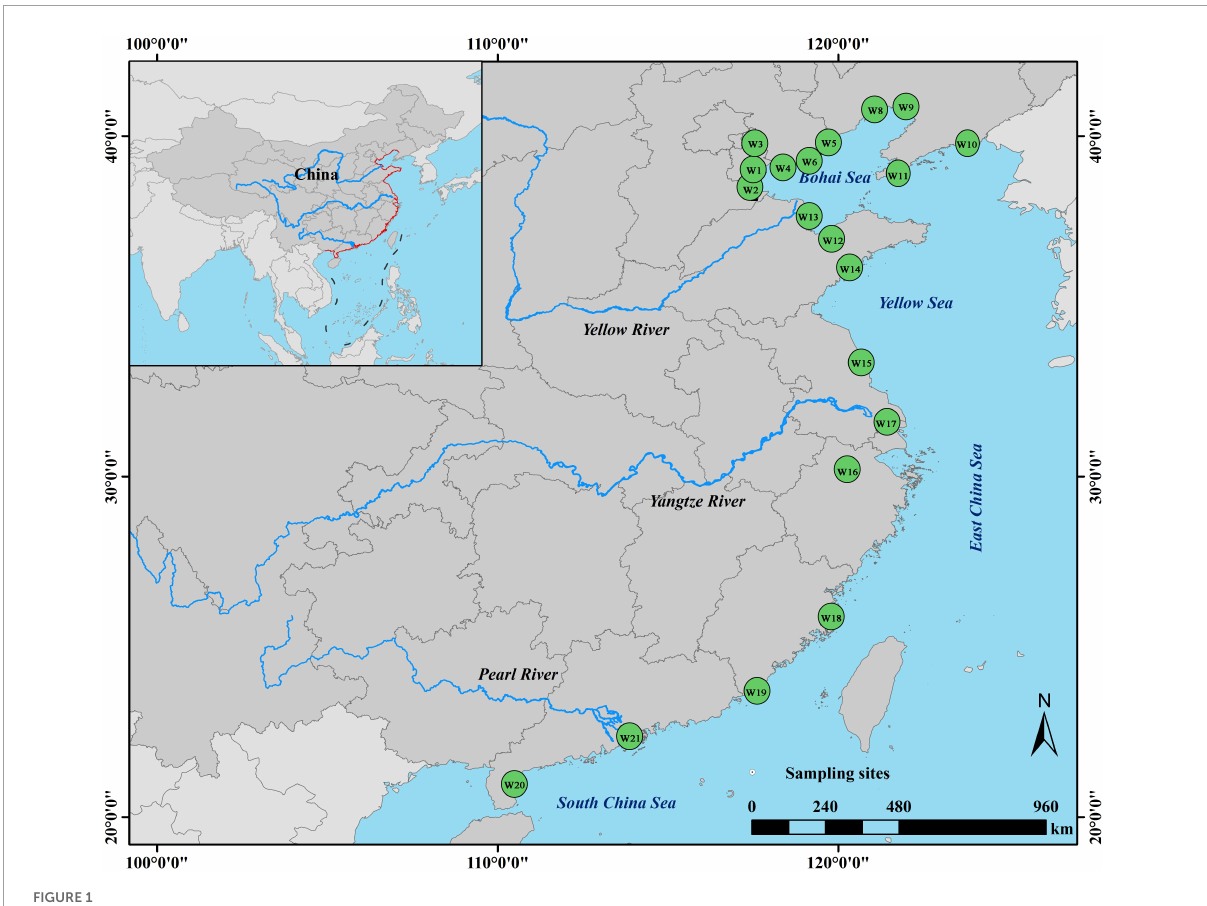
FIGURE1 Geographic map of sampling sites in China’s coastal wetlands.